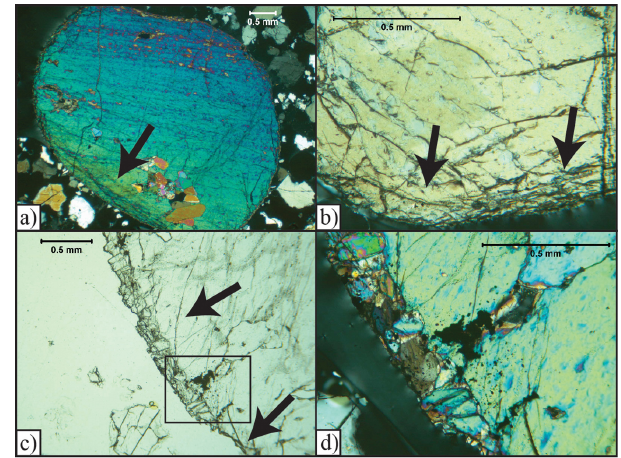
Figure 3. Photomicrographs of grains of olivine separated from sample of Igwisi Hills kimberlite. (a) Photomicrograph under cross-polarised light of a single xenocrystic olivine ellipsoid host- ing smaller internal domains of recrystallised olivine. Olivine grain shows pronounced fractures parallel to the grain boundary. (b) High magnification view of olivine grain boundary recording brittle de- formation manifest as arcuate fractures along the rim ( < 0.1mm) and at low angles to the grain boundary. (c) Grain boundary show- ing fine crystals grown along the rim of the larger olivine ellipsoid creating an irregular boundary. Fractures within the main crystal appear to bend towards the finer crystal rim and terminate within it. Again the fine-grained rim is not continuous (absent from the bottom of the photo). (d) Cross-polarised view of box in panel (c) highlighting the fine-grained crystal rim. Arrows in all figures point to the pronounced curved